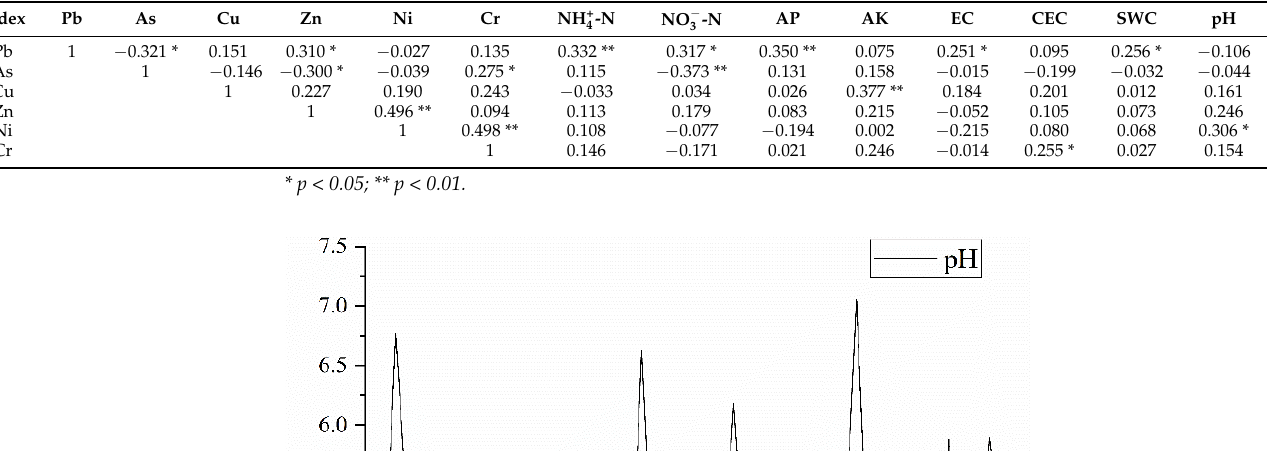
Table 3. Correlation analysis between soil heavy metals and soil physical and chemical properties.